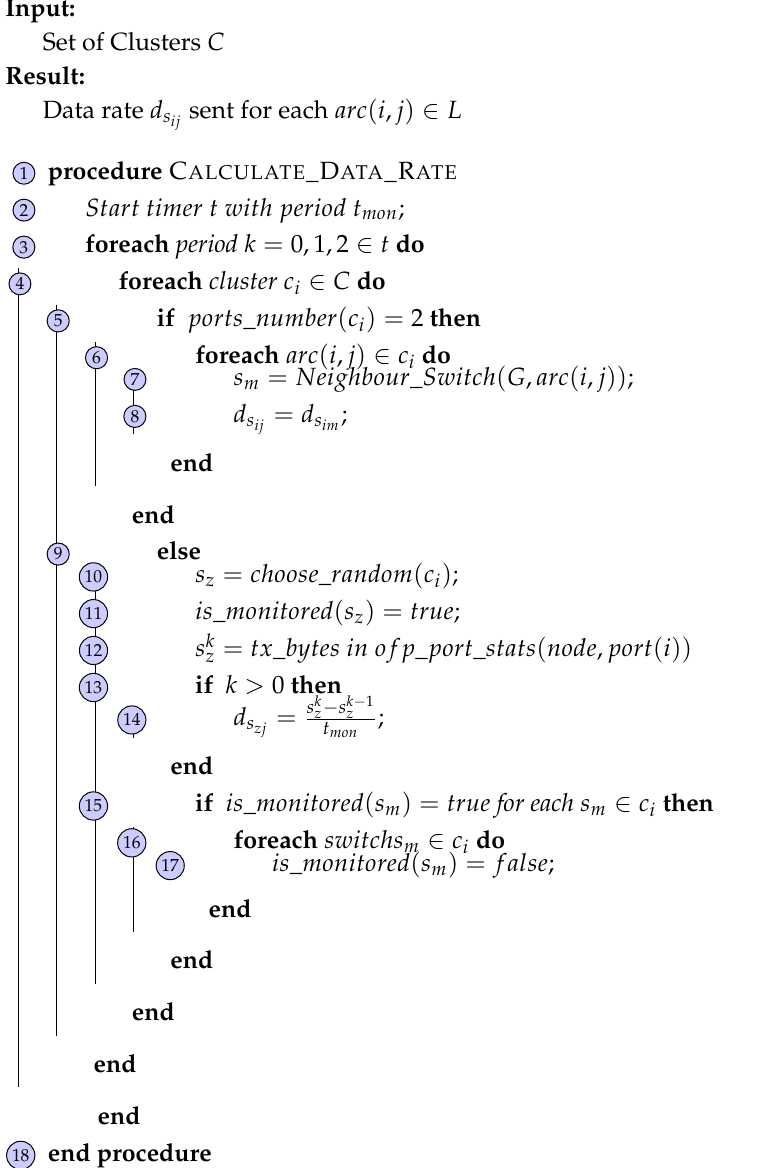
Algorithm 2: Calculate Data Rate